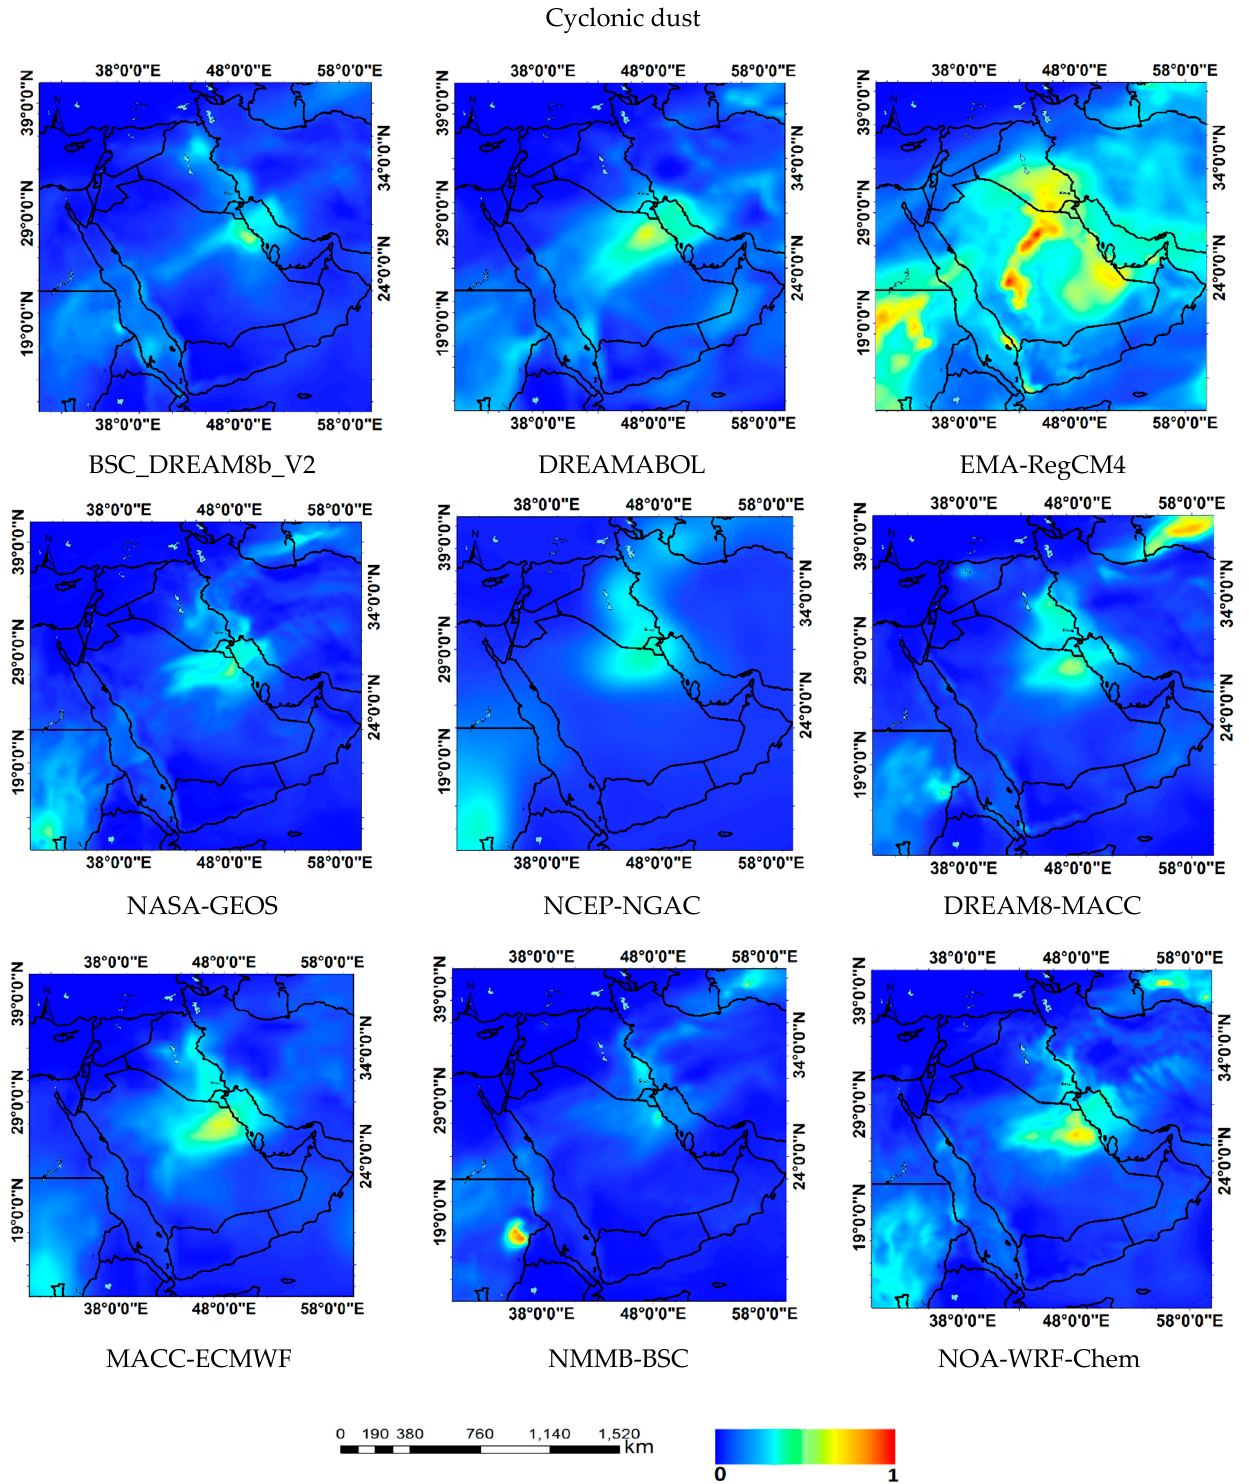
Figure 4. Spatial distribution of AOD forecasts from the nine examined models at 07:00 UTC on 2 December 2016 (cyclonic dust storm). AODs higher than 1 are also plotted in red here and in the following figures.